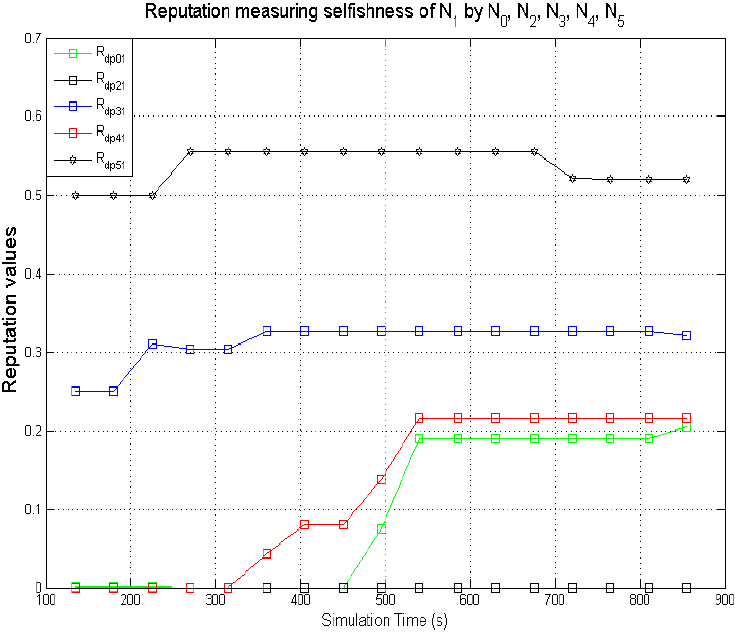
Figure 13. The reputation values ( R dp ) for N 1 computed by N 0 , N 2 , N 3 , N 4 , & N 5 . For node N 0 to compute the total reputation values of the target node N 1 , N 0 aggre- gates the genuine second-hand reputations from nodes N 2 and N 4 before computing it with its own directly measured reputation values to get the total reputation values for N 1 . Their subsequent trustworthiness with regards to the accuracy of second-hand reputa- tions is updated